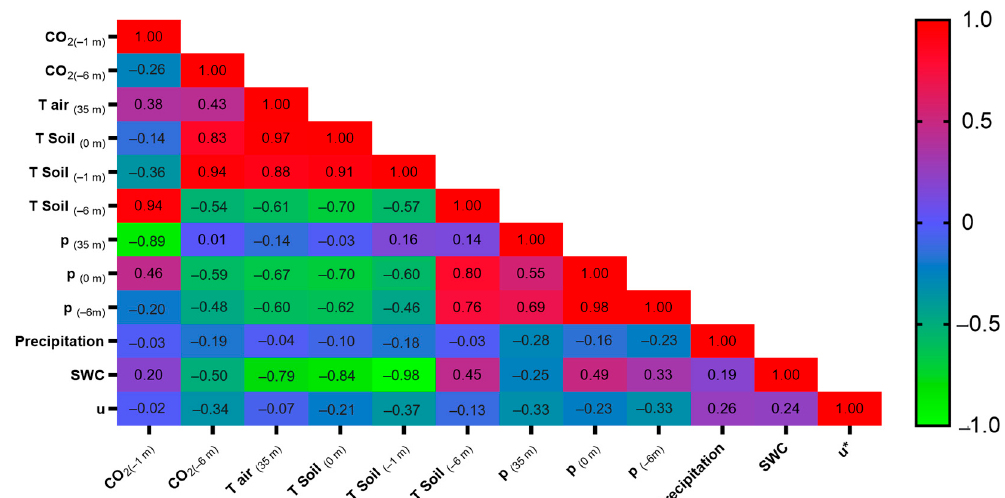
Figure 6. Heat map based on Pearson’s correlation test matrix of and hourly data including CO 2 molar fraction ( − 1 m and − 6 m) ( χ c), soil water content (SWC), u* (friction velocity), temperature (max) (T, at − 6 m and 0 m), soil air pressure ( − 6 m), atmospheric pressure (p, at 35 m and 0 m), and precipitation (P). The correlations were calculated when there was a measurement of CO 2 at − 6 m. Appl. Sci. 2021 , 11 , x FOR PEER REVIEW